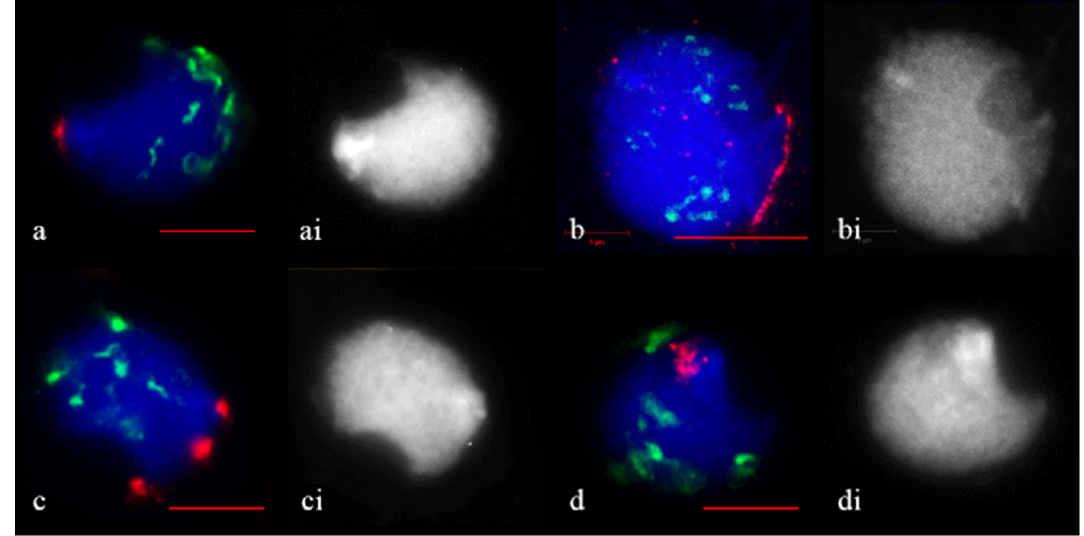
Figure 3. Telomere associations in 5R(5D) × R. Zygotene. ( a ) A tight telomere cluster. ( b ) Telomeres formed a part of circular arc. ( c ) Telomere clumps. ( d ) Diffuse telomere cluster. ( ai – di ) the same as ( a – d ), DAPI counterstaining. Telomeres are stained red , centromeres, green . Scale bar = 10 μ m. In the 1Rv(1A) × R and 6R(6A) × R hybrids, telomere associations in the early stages of prophase were similar, but were substantially different relative to wheat and the 2R(2D) × R hybrids. At leptotene, in meiocytes with two nucleoli, centromeres formed diffuse structures, and telomeres associated into large or small groups (Figure 4a–c); in some meiocytes these groups localized along the nucleus circumference (Figure 4a,c). During the leptotene-to-zygotene transition and at early zygotene, telomere associations represented groups of various shapes and sizes (Figure 4d–i), clumps localized along the nucleus circumference (Figure 4d,h) or the telomeres-formed cluster (Figure 4j). There was no clear polar arrangement of telomeres and centromeres, and the centromeres looked like a diffuse elongated structure in the overwhelming majority of meiocytes in which telomere clusters were not found (Figure 4e–i). In the meiocytes, where clusters of telomeres were found, the polar arrangement of centromeres and telomeres was preserved (Figure 4j). In general, an analysis of telomere associations in the 1Rv(1A) × R hybrids shows that clustering of the telomeres occurred in 11.4% of the nuclei at early zygotene (Table 1). Telomeres localized along the nucleus circumference in 28.2% of the meiocytes or formed several large or small clumps in 60.4% of the meiocytes (Table 2). Similar associations of the telomeres were found in the 6R(6A) × R hybrids. However, more meiocytes with telomere clusters (27.6%) and fewer meiocytes with telomeres located along the nucleus circumference (8.3%) were found in the 6R(6A) × R hybrids than in the 1Rv(1A) × R hybrids (Table